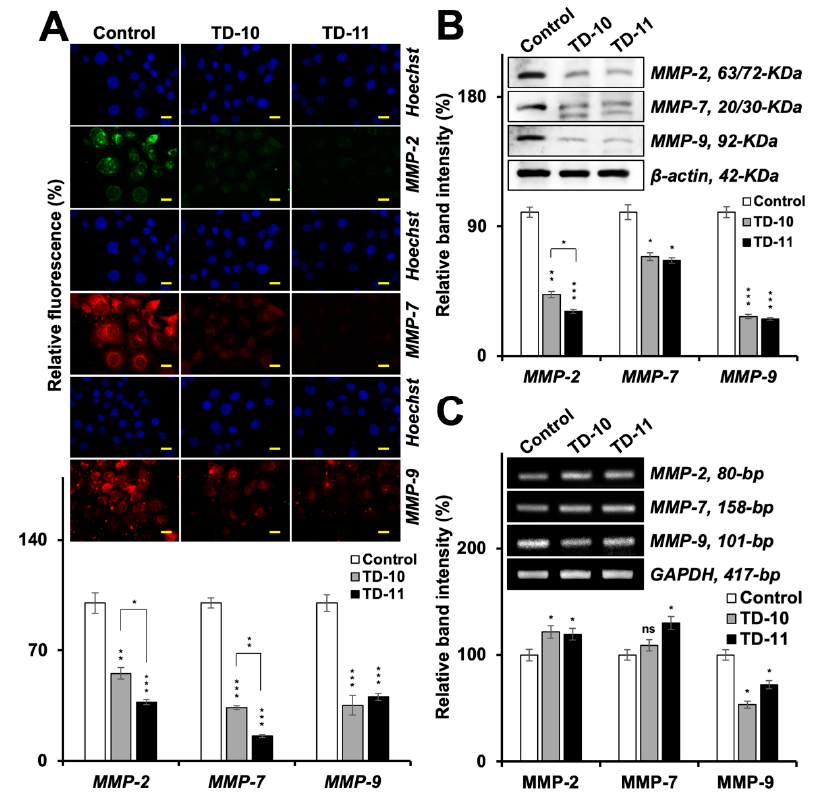
Figure 7. Analyses of MMPs in Panc-1 cells treated with TD-10 and TD-11. Immunostaining ( A ), Western blotting ( B ) and RT-PCR ( C ) showed downregulation of MMP-2 and MMP-7 proteins and inhibition of both protein and transcription of MMP-9. Scale 20 µm. Statistical significance was defined as p -values (*) where ns, * < 0.05, ** < 0.01 and *** < 0.001 represent not significant, significant, very significant and highly significant, respectively.